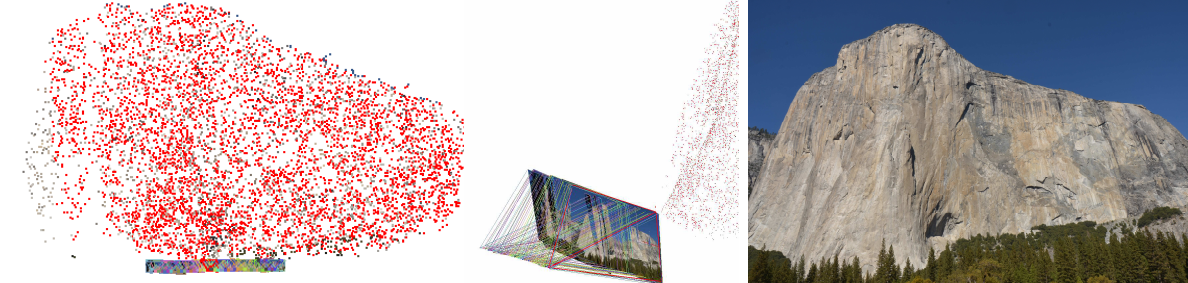
Fig. 3.1: El Capitan dataset. 42 images with 16 Megapixels each distributed in line at far distance from the object.